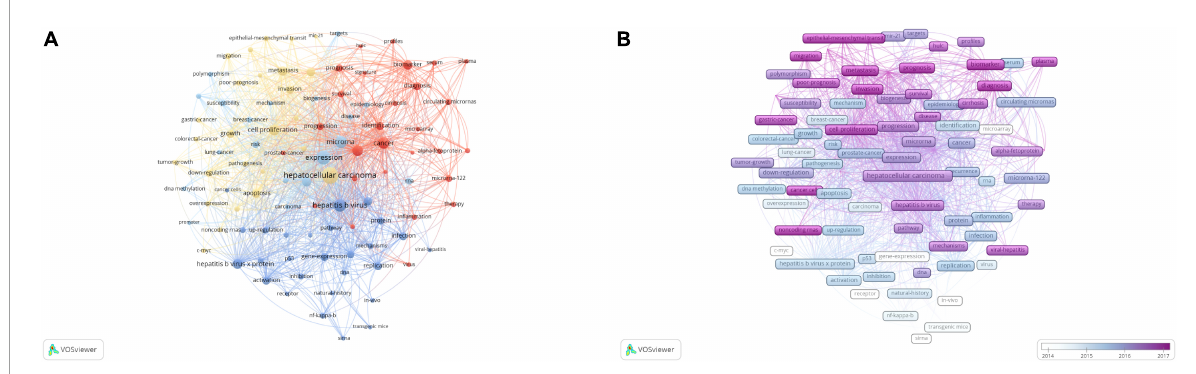
FIGURE4 The co-occurrence analysis of non-coding RNA and hepatitis B virus (HBV)-related hepatocellular carcinoma. (A) The co-occurrence cluster analysis of the top 100 keywords. (B) The overlay map of the top 100 keywords. Each node represents a keyword. The size of nodes represents the publication number. The connection between nodes represents collaboration. The distance and thickness of the connection represent the relative strength of the